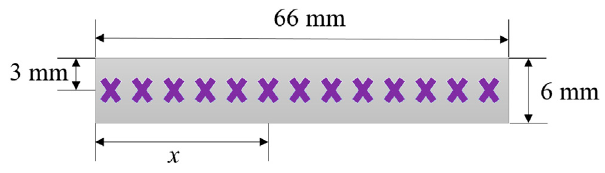
FIGURE 3 | The schematic of probe measuring setpoints in the radial